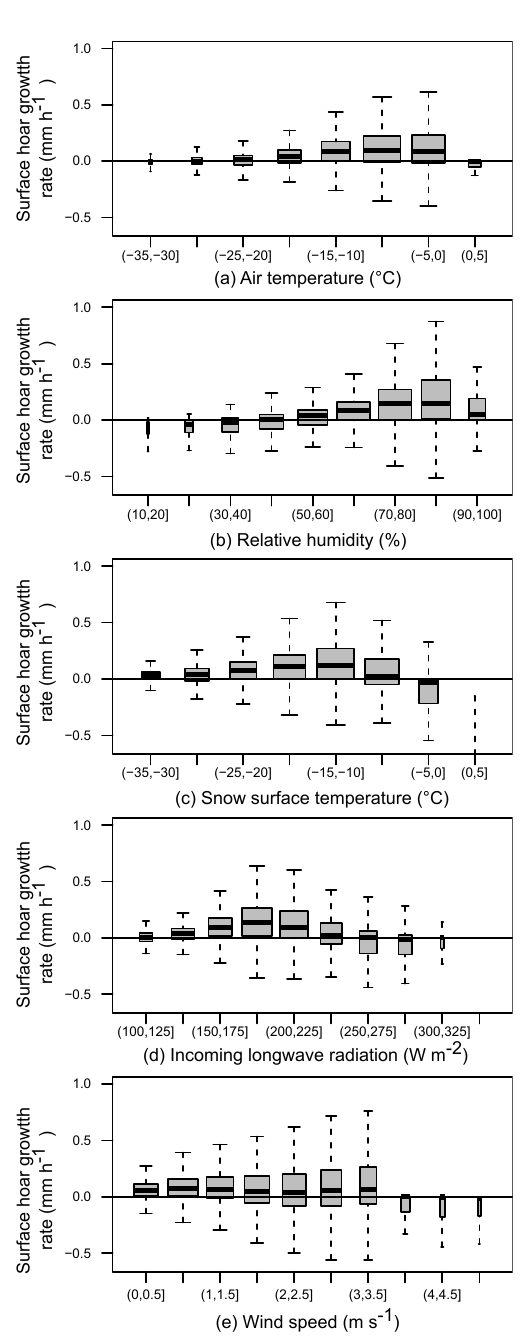
Figure 2. Surface hoar growth rates modelled by SNOWPACK for input values of (a) air temperature, (b) relative humidity, (c) mod- elled snow surface temperature, (d) incoming longwave radiation, and (e) wind speed. Plots are based on hourly SNOWPACK inputs and outputs over 6months at 393 HRDPS grid points (670046 total growth rates). For a given range of input values the median growth rate is shown with a black line, boxes span the interquartile range of growth rates, whiskers span growth rates within 1.5 times the interquartile range, and outliers are not shown. Box widths are pro- portional the square root of the number of inputs in each